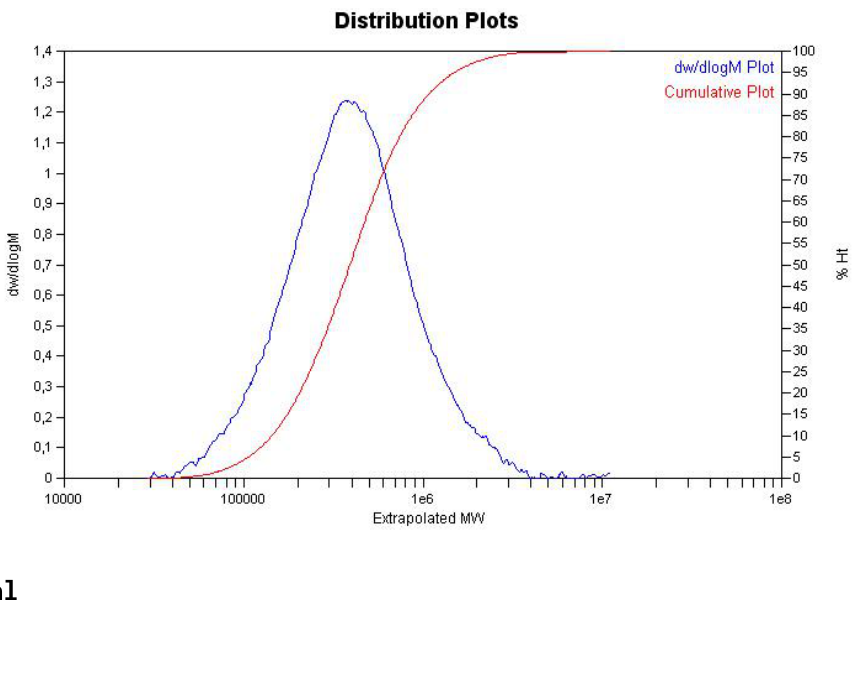
Figure 9. GPC-trace of PS- co -poly(1,3-CHD) prepared by the action of Ti-8